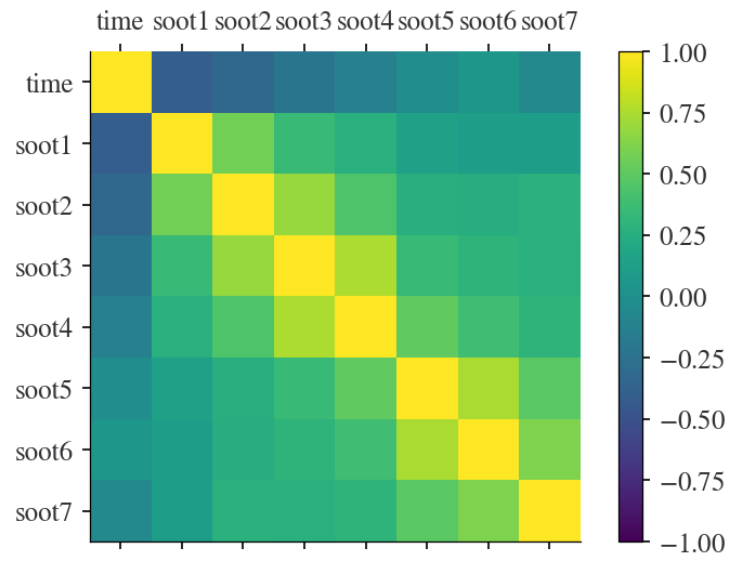
Figure 14. Correlation matrix soot concentration plot.